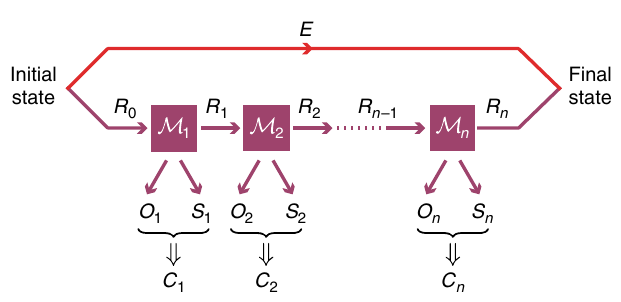
Fig. 4 Sequential processes. Each map in the sequence M i outputs O i , which describes the information that should be kept secret, and S i , describing some side information leaked by the map, together with a “ memory ” system R i , which gets passed on to the next map M i þ 1 . In each step, an additional classical value C i is calculated from O i and S i